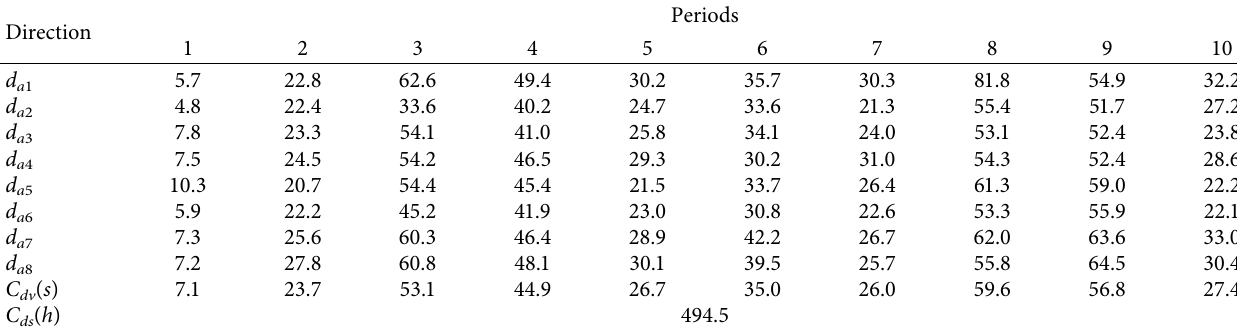
Table 10: Analysis results of the average vehicle delay in scheme C. Direction